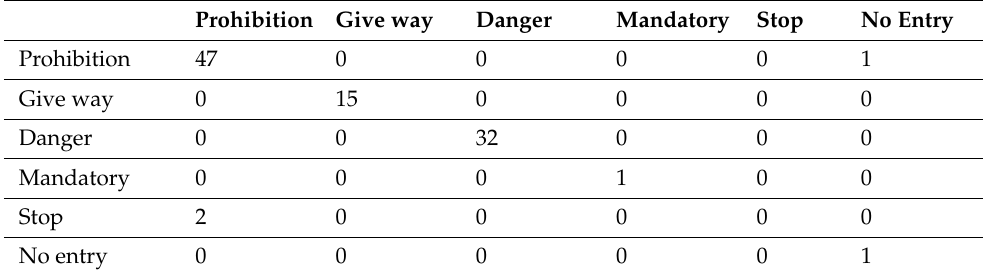
Table 3. Confusion matrix of the traffic sign recognition results.